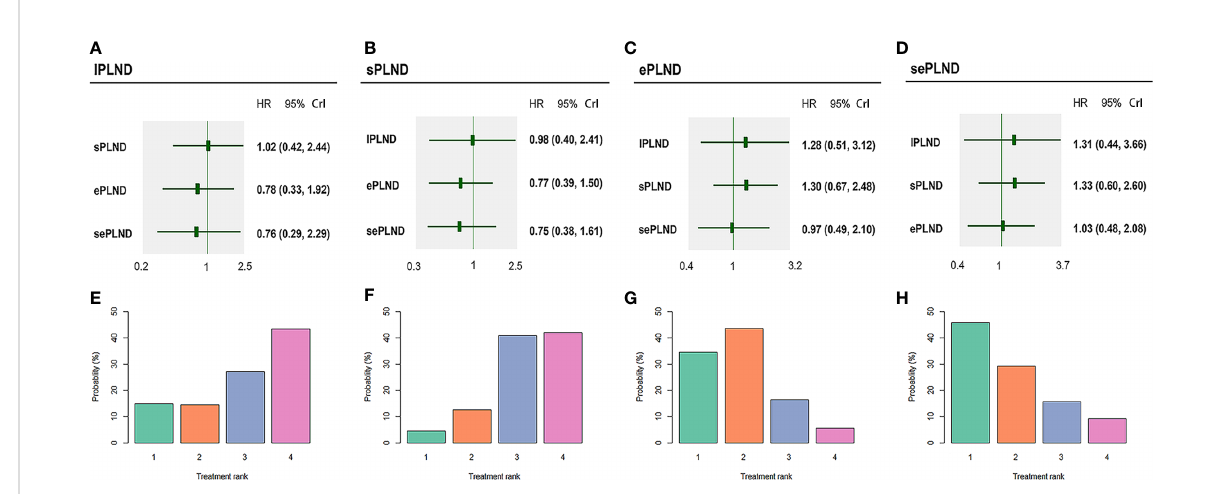
FIGURE 7 Bayesian network analysis results for DSS and rank probabilities of each PLND template based on the random effects model. (A) Other three PLND templates vs. lPLND template. (B) Other three PLND templates vs. sPLND template. (C) Other three PLND templates vs. ePLND template. (D) Other three PLND templates vs. sePLND template. (E) Probabilities of ranking the lPLND template in the fi rst, second, third and fourth place among four PLND templates. (F) Probabilities of ranking the sPLND template in the fi rst, second, third and fourth place among four PLND templates. (G) Probabilities of ranking the ePLND template in the fi rst, second, third and fourth place among four PLND templates. (H) Probabilities of ranking the sePLND template in the fi rst, second, third and fourth place among four PLND templates. DSS, Disease speci fi c survival. PLND, Pelvic lymph node dissection. HR, Hazard ratio. CrI, credible interval. lPLND, limited pelvic lymph node dissection. sPLND, standard pelvic lymph node dissection. ePLND, extended pelvic lymph node dissection. sePLND, super-extended pelvic lymph node